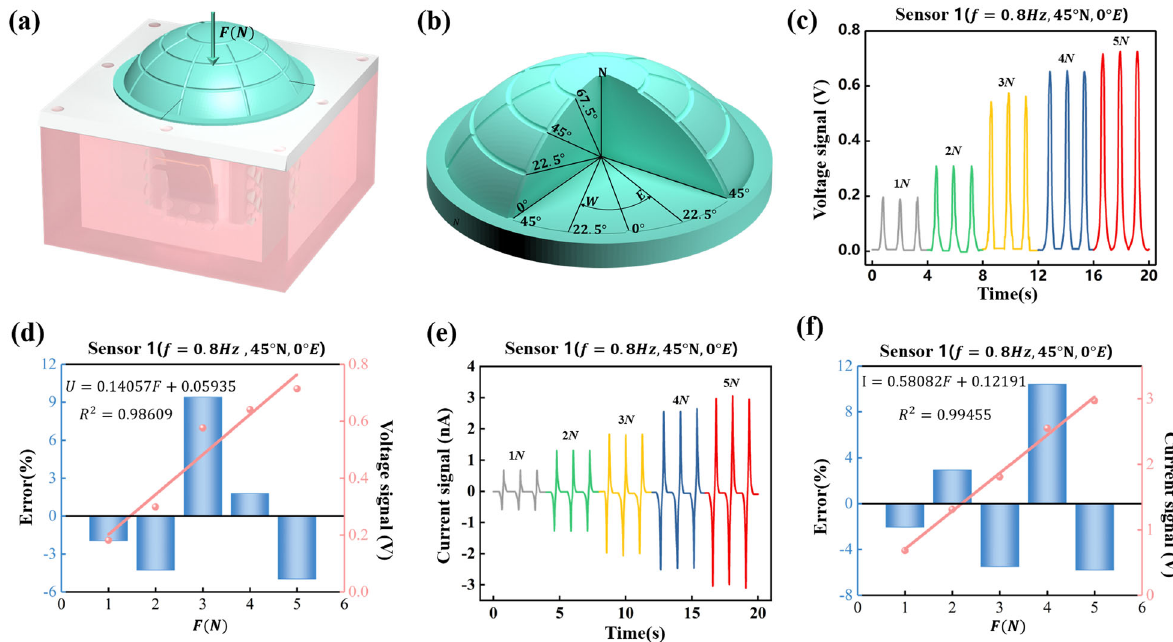
Fig. 2 The results of the TPTS excited by a linear motor. a Deformation diagram of sensor units under external load. b Labels on the fl exible cover surface using longitude and latitude lines. c The open circuit voltage responding to external load magnitude from 1 N to 5 N . d Fitted linear relationship between open circuit voltage and external load magnitude. e The short circuit current responding to external load magnitude from 1 N to 5 N . f Fitted linear relationship between short circuit current and external load